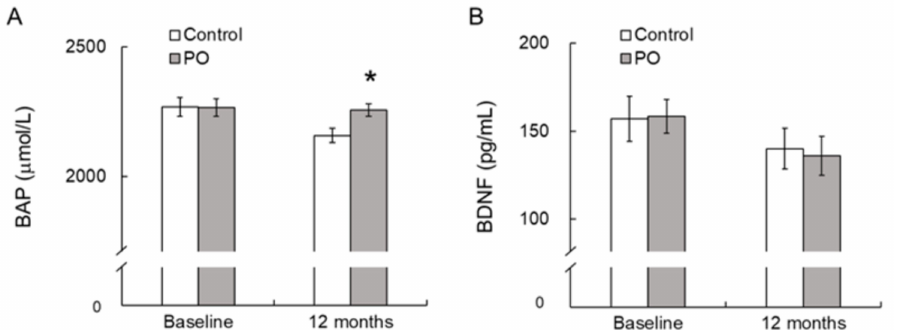
Figure 4. Effect of dietary PO on serum BAP ( A ) and BDNF levels ( B ) in the PO-intake and control groups. Values are mean ± SE. * p < 0.05, compared with the control value. Control group, n = 24–33; PO group, n = 35–42. BAP, biological antioxidant potential; BDNF, brain-derived neurotrophic factor; PO, perilla seed oil-intake group.